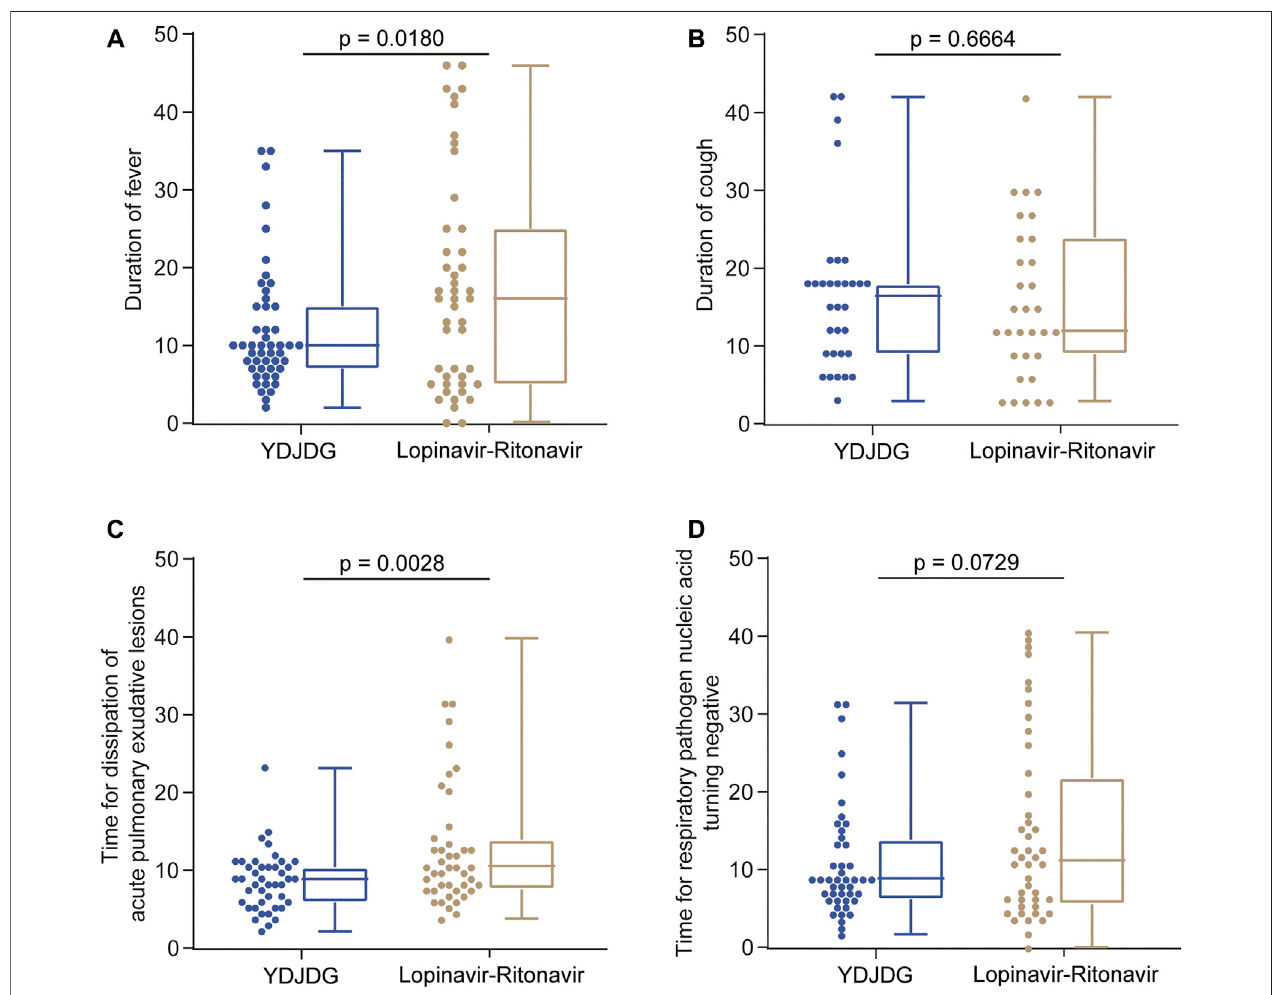
FIGURE6| Durationofsymptomrecovery.ComparisonofthedurationoffeverintheYDJDGandlopinavir-ritonavirgroups (A) ,thedurationofcoughintheYDJDG and lopinavir-ritonavir groups (B) , duration for dissipation of acute pulmonary exudative lesions (C) , and duration for the nucleic acid test to turn negative (D) .